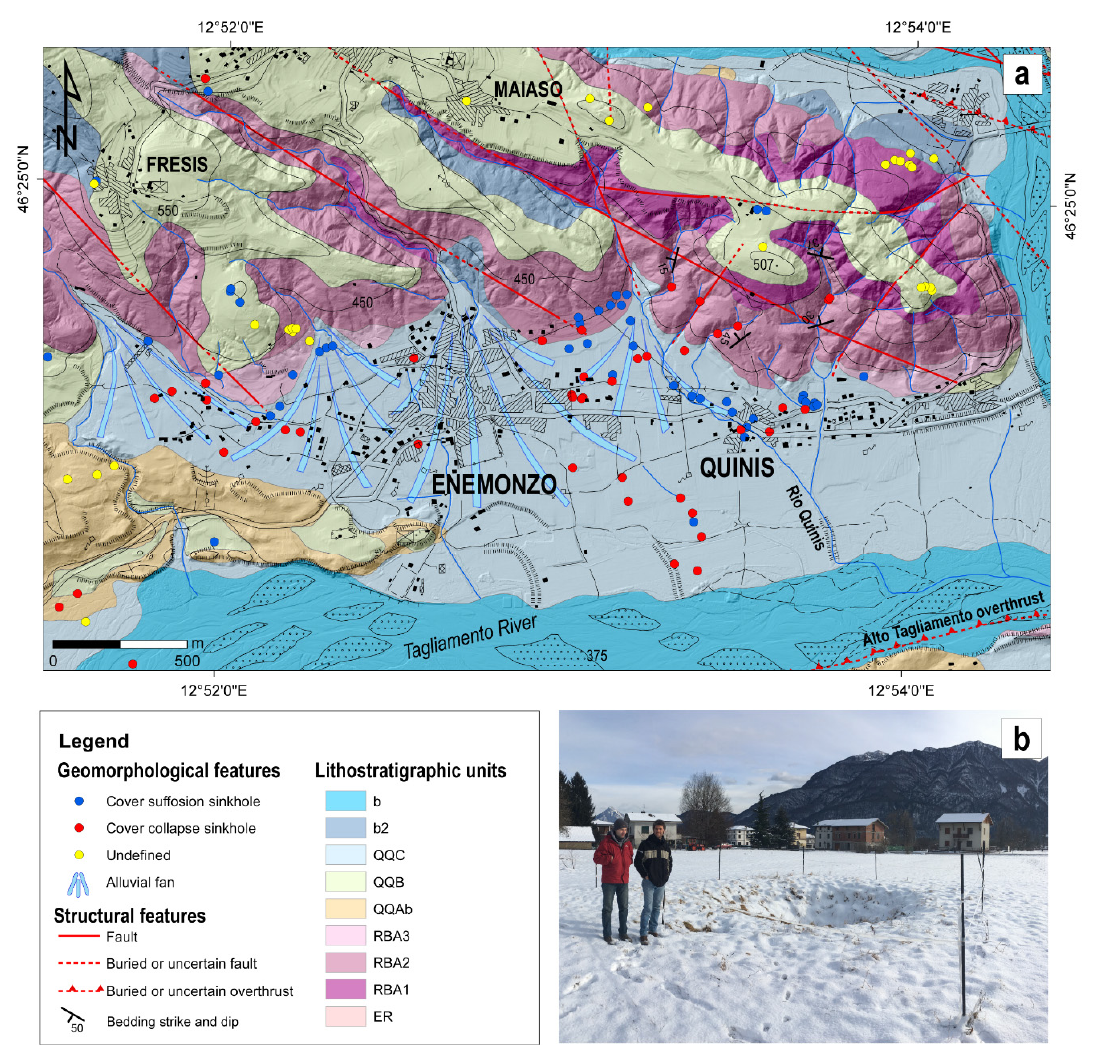
Figure 4. ( a ) Geological and geomorphological map of the study area (modified after [61]). Lithostratigraphic units: ( b ) actual alluvial deposits; (b2) eluvial-colluvial deposits; (QQC) fluvial gravel and sand; (QQB) glacial till; (QQAb) fluvial conglomerates. All these units are Pleistocene–Holocene in age. (RBA3) marls and dolostones member; (RBA2) gypsum and grey dolostones member; (RBA1) red shales member. RBA1, RBA2 and RBA3 belong to the Raibl Formation, Triassic in age. (ER) Siera group (Triassic age), mainly limestones and dolomitic limestones badly stratified, mainly massive. ( b ) One of the cover collapse sinkholes present in the area initially formed in 1977. It